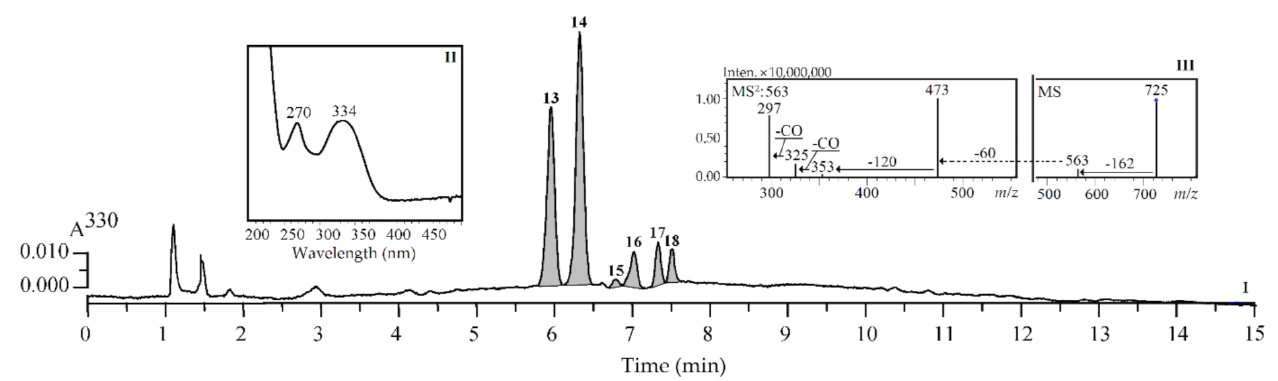
Figure 3. High-performance liquid chromatography with photodiode array detection (HPLC-PDA: 330 nm, I) of S. repens SPE-2 fraction from leaves (control 1 sample), absorption spectrum ( II ) and mass spectrum of compound 13 (negative ionization, III ). Compounds: 13 —schaftoside-2 (cid:48)(cid:48) - O -glucoside (sileneside E); 14 —schaftoside; 15 —isovitexin-2 (cid:48)(cid:48) - O -glucoside (meloside A); 16 —isovitexin; 17 —swertisin-2 (cid:48)(cid:48) - O -glucoside; 18